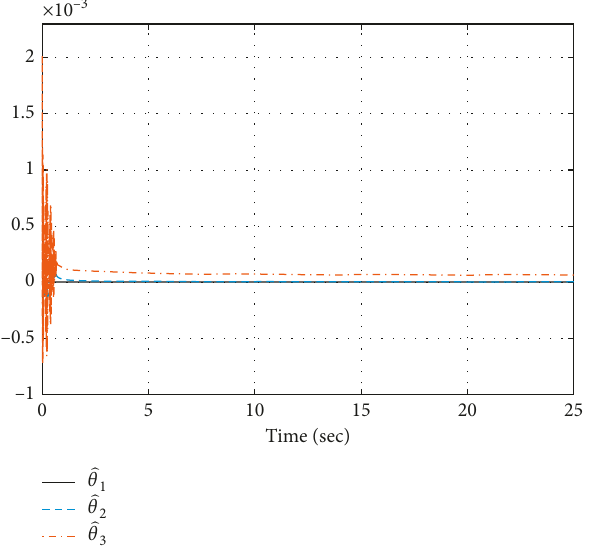
Figure 4: Evolution of the estimation of the unknown constants